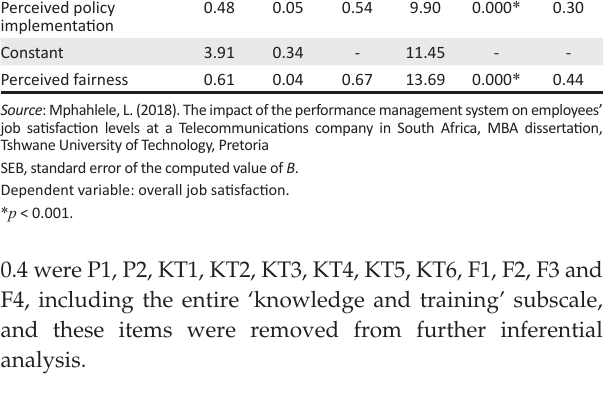
Table 4 details the results of the correlation analysis and Table 5 the results of the regression analysis. The analysis in Table 5 contains both alpha and regression coefficients; β ,